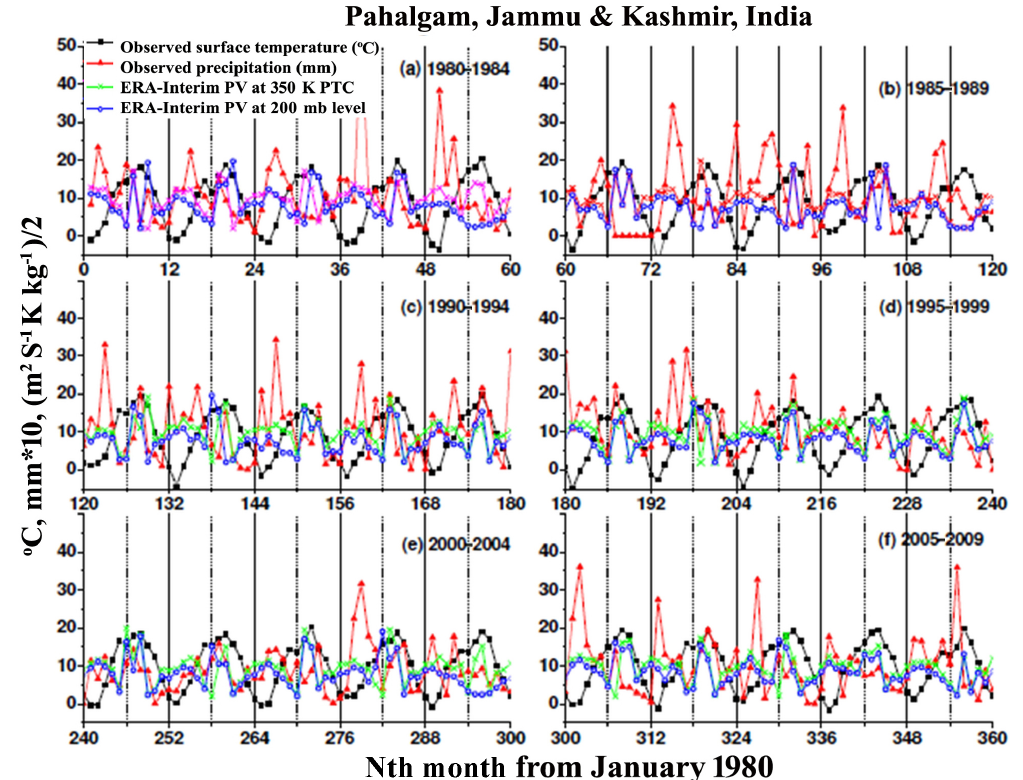
Figure 10. Same as Fig. 8 but for